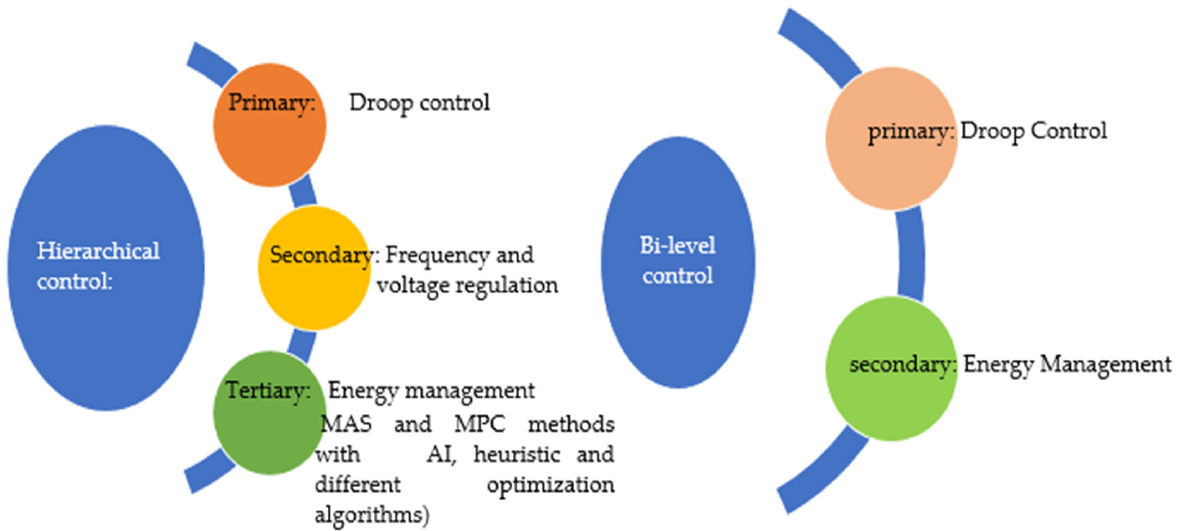
Figure 7. Different levels of control in hierarchical architecture.